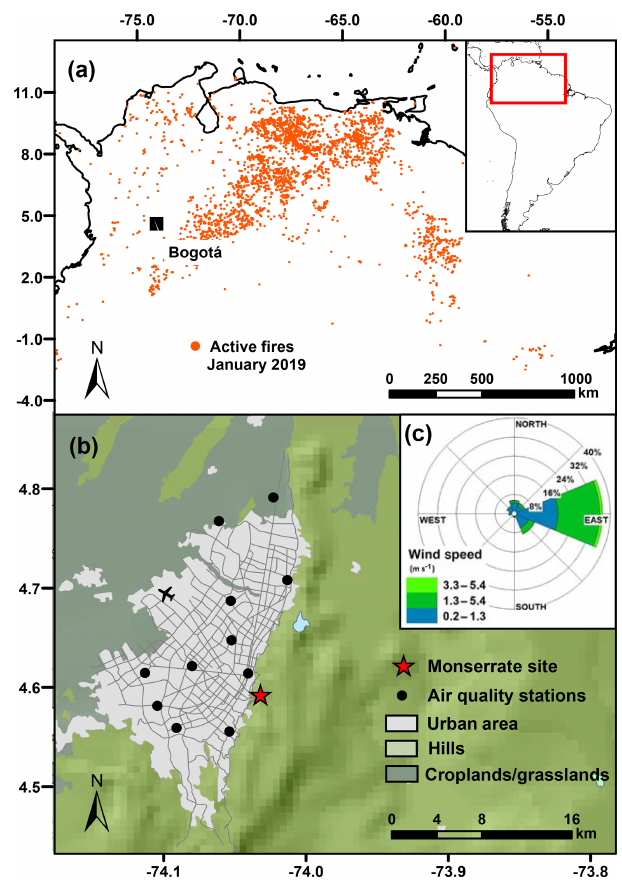
Figure 1. (a) Geographic location of the northern South America (NSA) domain as defined in this study and locations of MODIS hotspots during January 2019. The inset shows the location of NSA relative to South America. (b) Location of the Monserrate site (star) near Bogotá and the air quality (AQ) stations (filled circles). Colors in the map indicate land-use type, and the shading shows terrain height variations. (c) Wind direction observed at the Monserrate site during the period May 2016–April